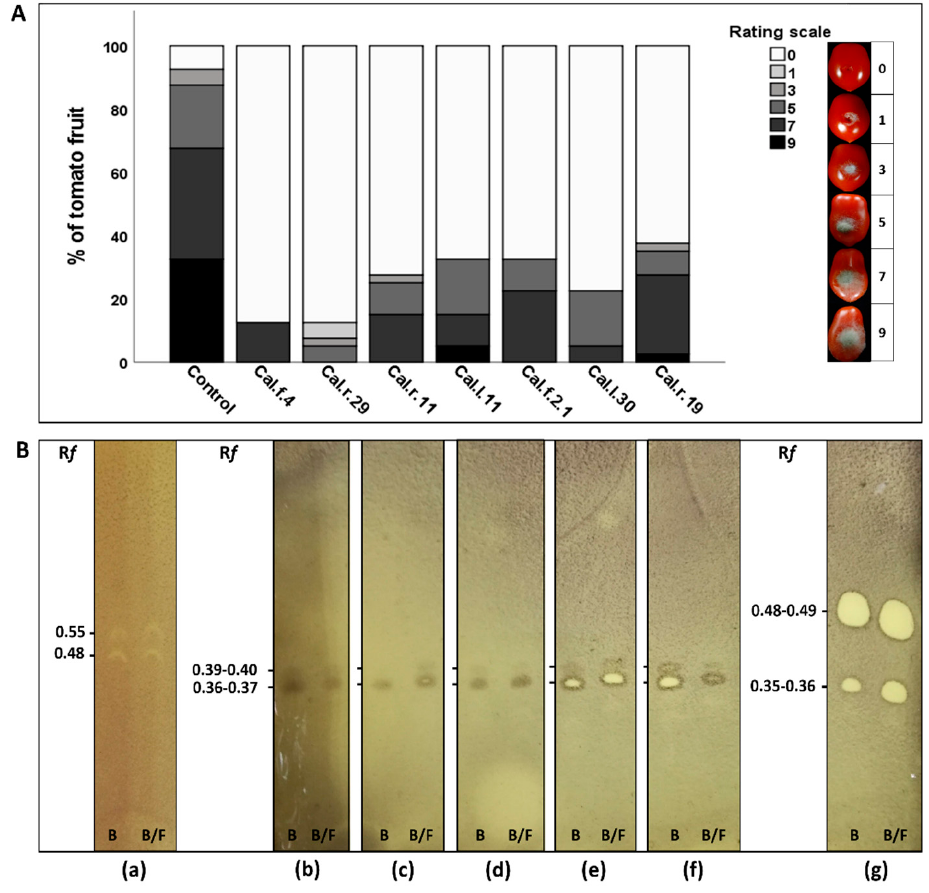
Figure 9. ( A ) Infected tomato fruit (%) as assessed by color in control ( B. cinerea ) and inoculated (both competitive bacterial strains and the pathogen) fruits (n = 20). Colored blocks within each column represent the percentage of fruit corresponding to the scale value of the disease severity of B. cinerea . Visual disease rating scale of symptoms caused by B. cinerea is represented as 0 = healthy fruits, 1 = 1–10%, 3 = 11–25%, 5 = 26–50%, 7 = 51–75% and 9 = >75% infected fruit area. ( B ) TLC-bioautography of antimicrobial agar diffusible secreted metabolites of bacterial endophytes ( a ) Cal.r.19, ( b ) Cal.l.11, ( c ) Cal.r.11, ( d ) Cal.f.2.1, ( e ) Cal.f.4, ( f ) Cal.l.30 and ( g ) Cal.r.29 produced when grown singly ( B ) and during confrontation with B. cinerea (B/F). Retention factor (R f ) values are marked on the image next to each inhibition zone of B. cinerea mycelial growth.